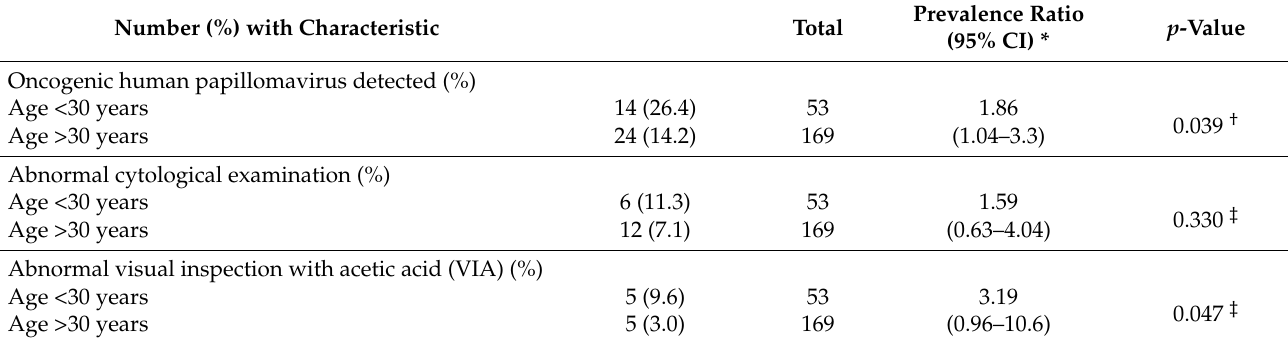
Table 1. Differences in the prevalence of positive screening tests by participant age-group (less than 30 years vs. 30 years of age or older) at the time of visual inspection with acetic acid (VIA) in women participating in community-based cervical cancer screening, 2017, Alta and Baja Verapaz,